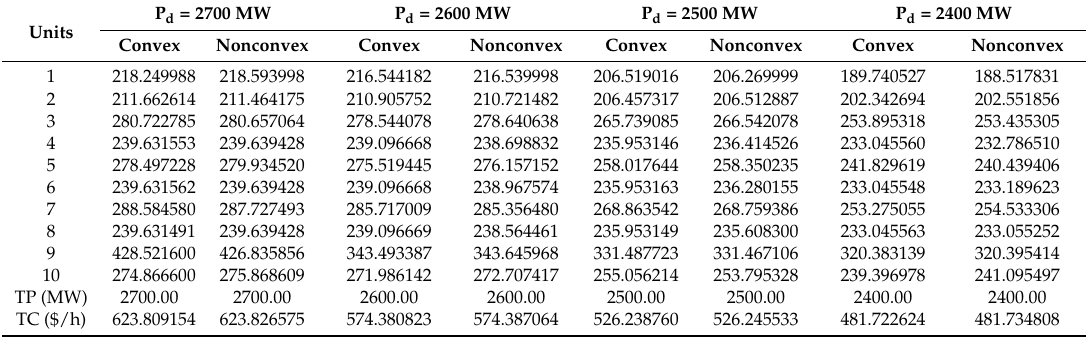
Figure 9. Cost-distribution around 30 run for system 2 (with valve point loading effects), P d = 2700 MW. Table 12. Summary of simulation results achieved by SDE for both convex and non-convex PED.